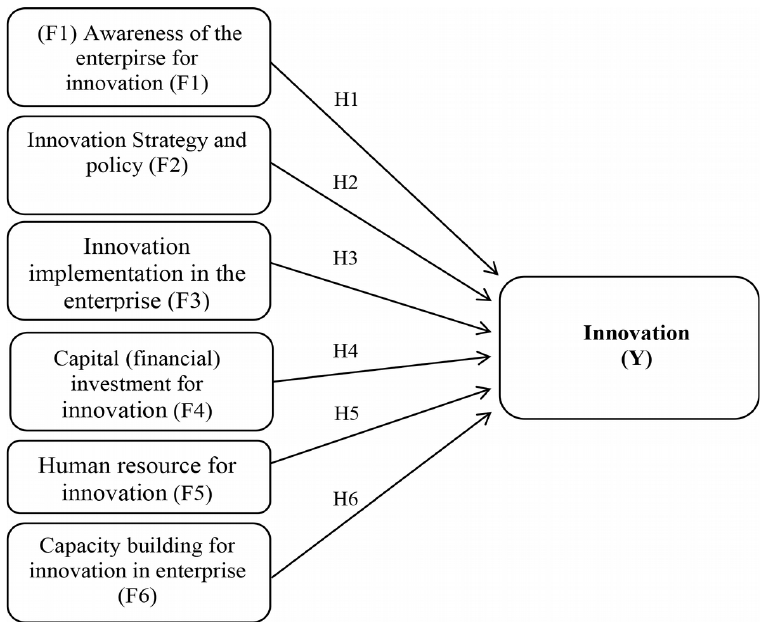
Figure 1. Research Model